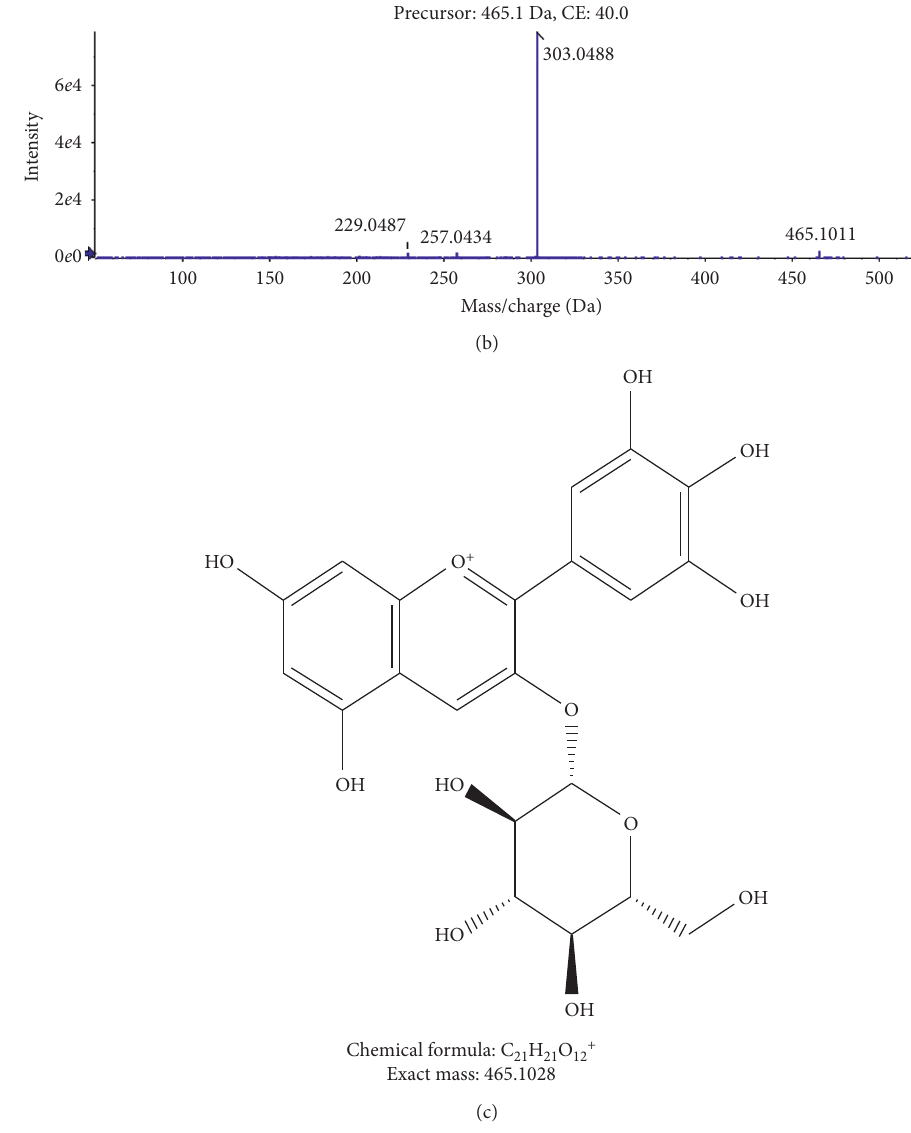
Figure 6: The first class two-level mass spectrogram and the possible structure formula of component